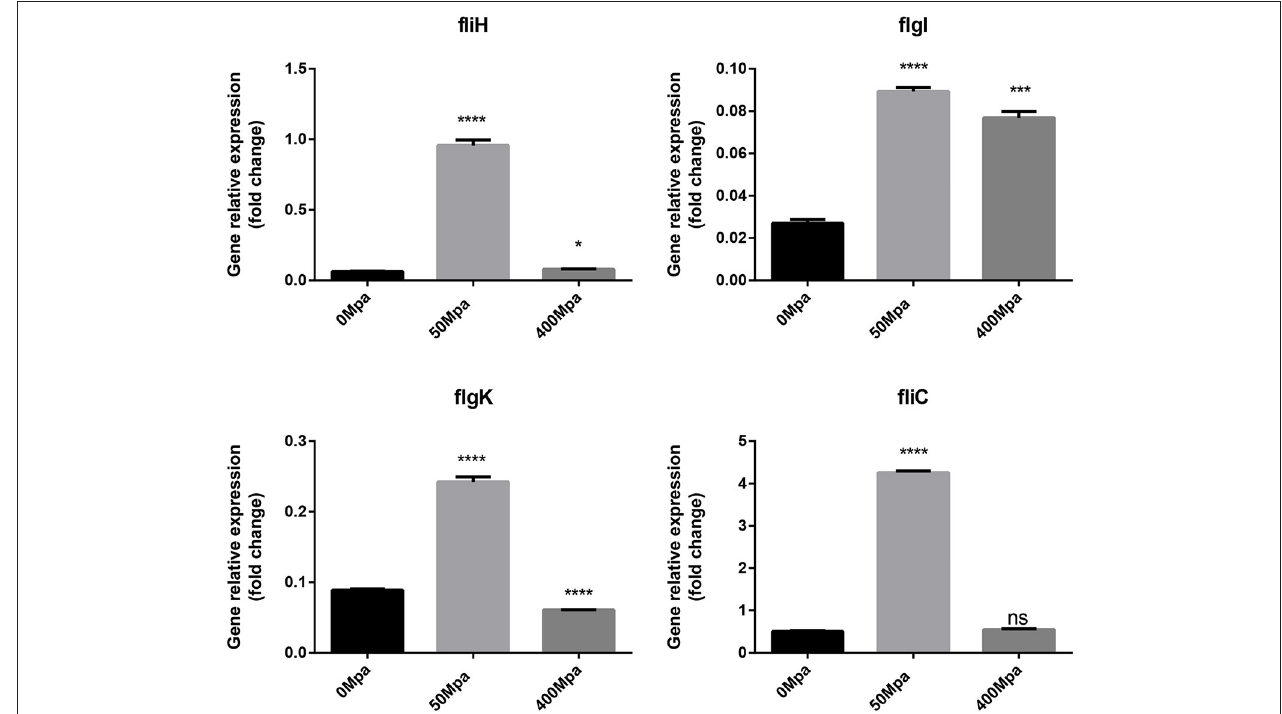
FIGURE 6 | Expression of flagellin genes in E. sakazakii treated with HHP. Asterisks indicate difference between control and different HHPs at * P < 0.05, ** P < 0.01, *** P < 0.001, and **** P < 0.0001.